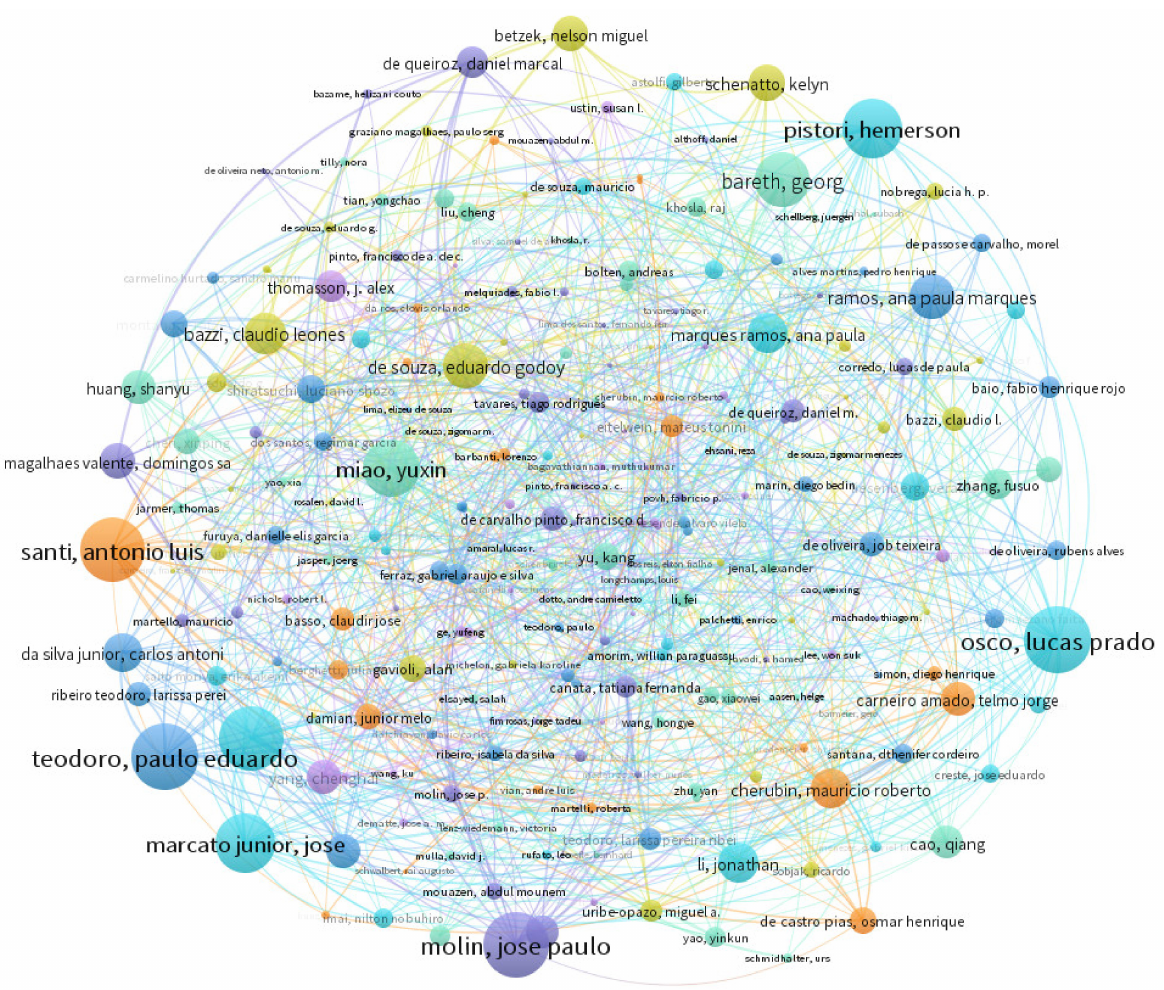
Figure 20. Author influence